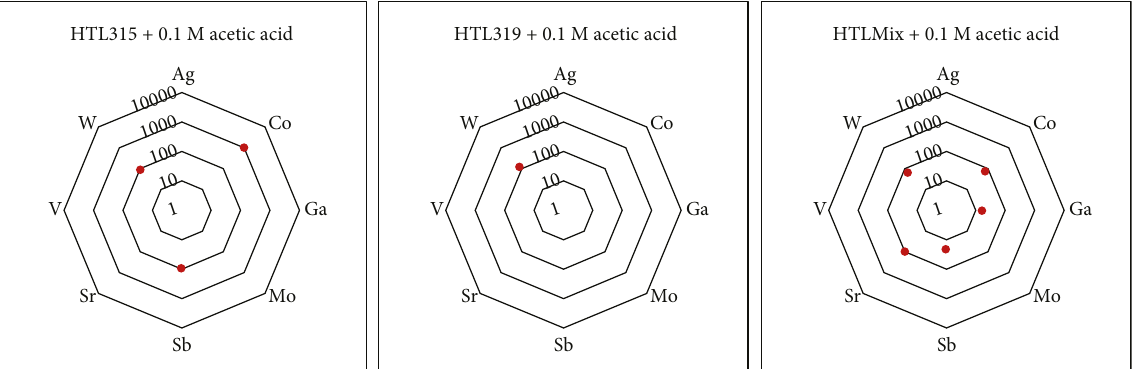
Figure 7: Concentration (in ppb) of the “ at risk ” elements in each sample reacted with 0.1M acetic acid at 70 ° C temperature under 1 bar pressure in batch rotating shakers (absence of data points re fl ects concentrations below the limits of detection).